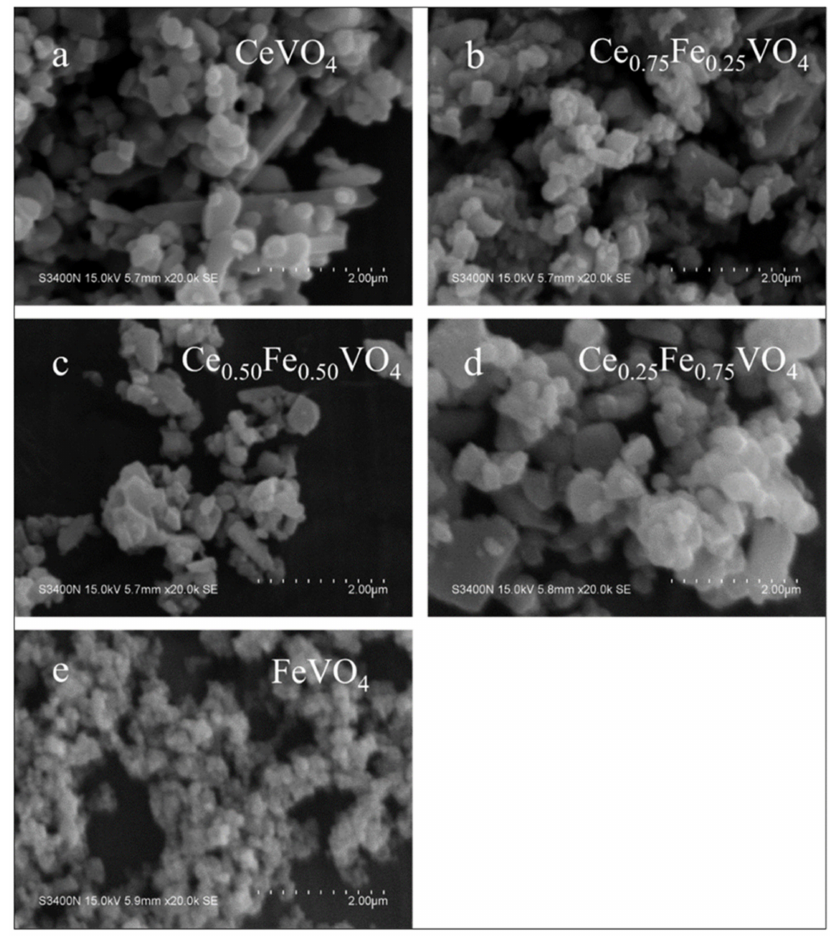
Figure 3. SEM images of Ce 1 − x Fe x VO 4 . ( a ) CeVO 4 ; ( b ) Ce 0.75 Fe 0.25 VO 4 ; ( c ) Ce 0.50 Fe 0.50 VO 4 ; ( d ) Ce 0.25 Fe 0.75 VO 4 ; ( e ) FeVO 4